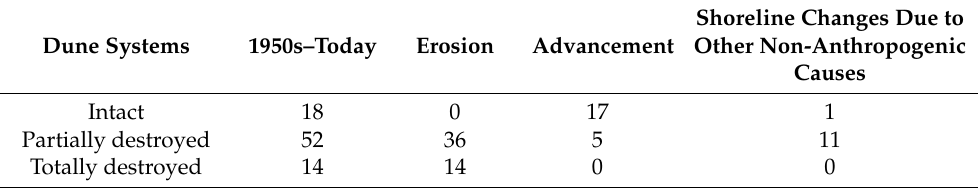
Table 3. Summary of the comparison between the dune systems in the 1950s and today and a summary of the number of municipalities where shoreline erosion or advancements have been observed, or where shoreline changes are due to other non-anthropogenic causes.